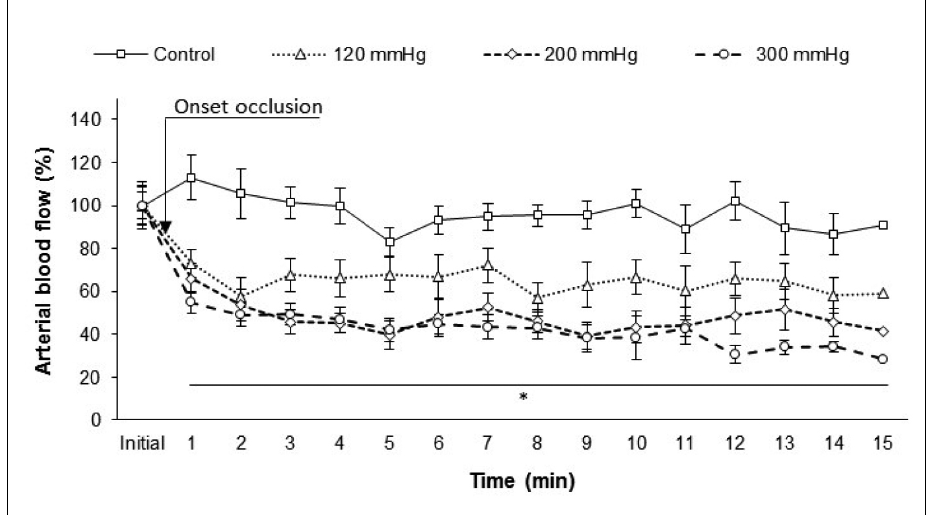
arterial blood flow in - tensity in experimental groups during 120; 200 or 300 mmHg pressure occlusion and in control group without